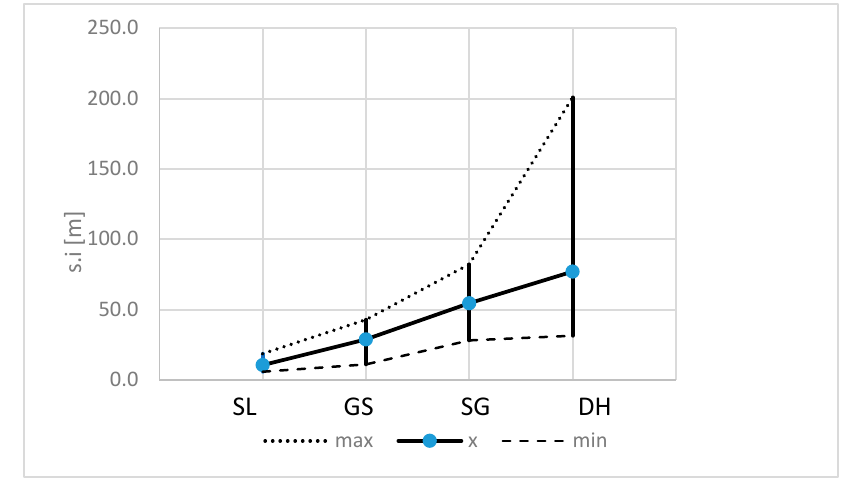
Figure 5. Average lengths of the curved sections in various competitions.